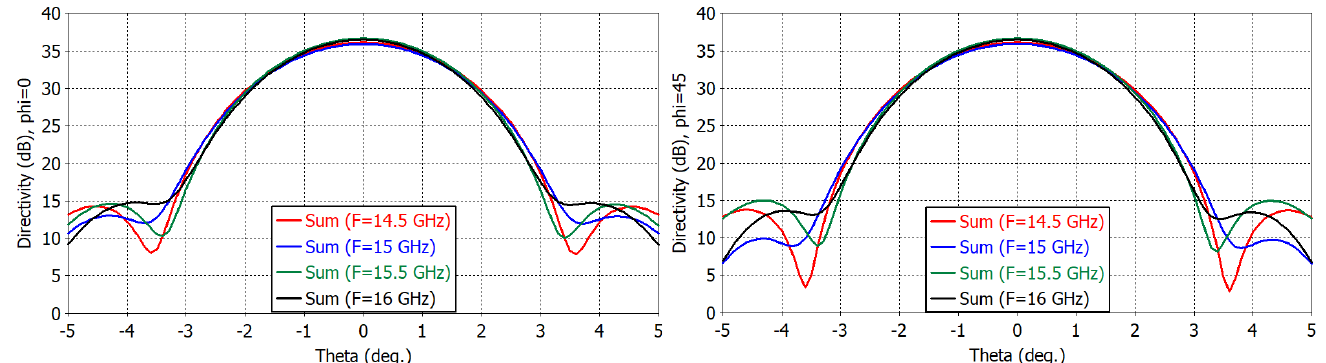
Figure 14. Reflection and coupling coefficients of the feed illuminating the reflector antenna.